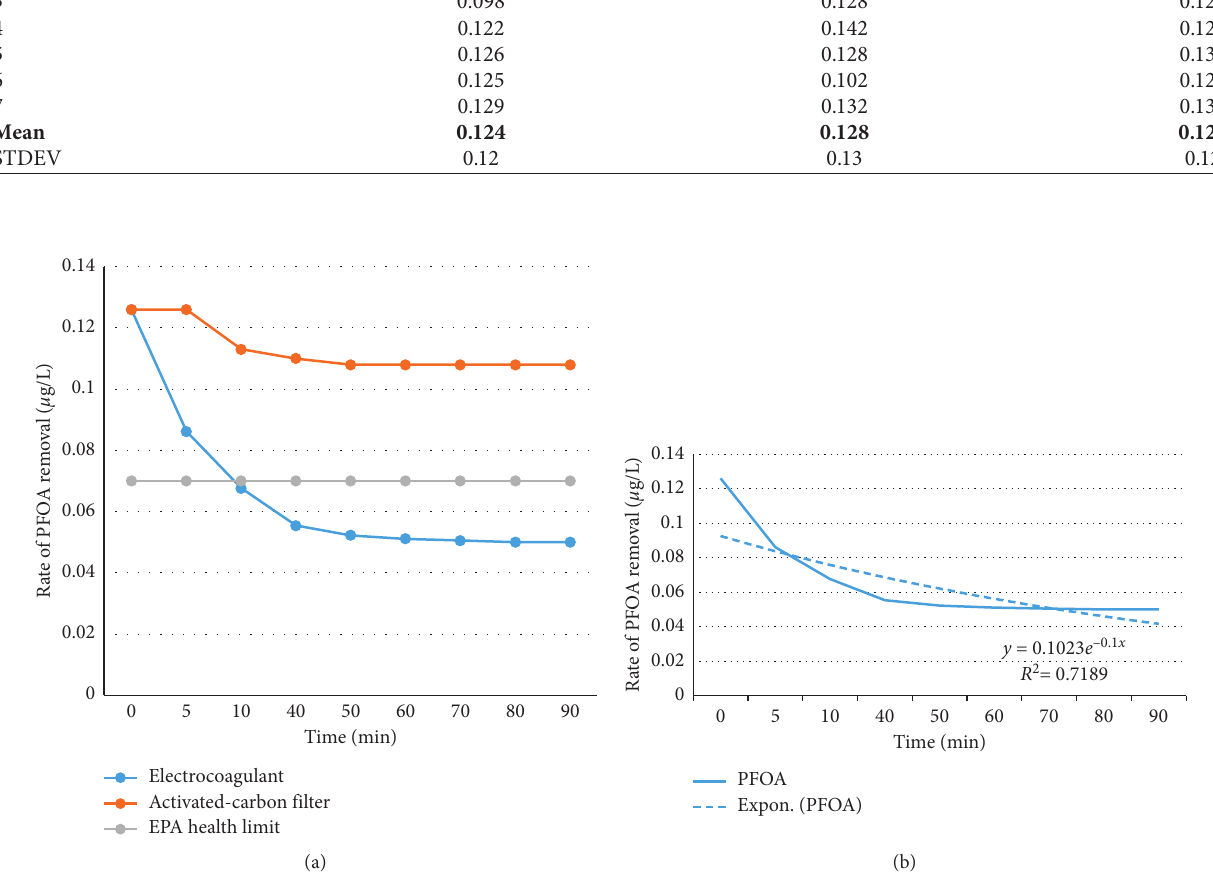
Figure 3: (a) Rate of PFOA removal by electrocoagulation compared with activated carbon and (b) negative exponential model of PFOA